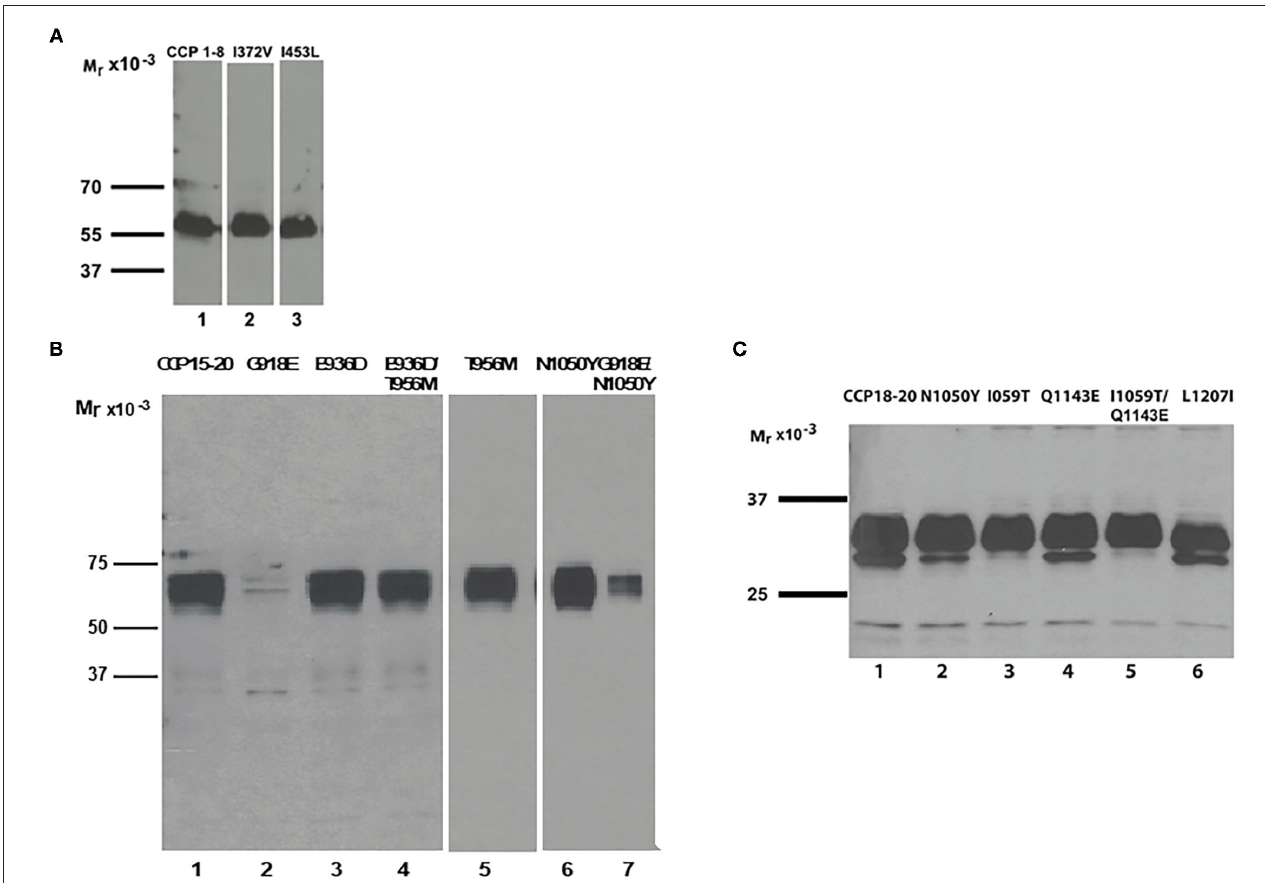
FIGURE 2 | Recombinant expression of CFH variants. Western blots of supernatants from transfected wild-type and variant constructs. (A) Recombinant expression of variants I372V (lane 2) and I453L (lane 3) shows secretion comparable to wild type CCP 1–8 (lane 1). (B) Wild type CCP 15–20 as control (lane 1). Secretion of variant protein G918E is undetectable (lane 2). The SNP N1050Y displays higher secretion than WT (lane 6). The combined variant G918E/N1050Y has markedly reduced secretion (lane 7). Variant T956M has normal secretion (lane 5). Combined variant T956M/E936D and the SNP E936D also demonstrate normal secretion (lanes 3 and 4). (C) Wild type CCP 18–20 as control (lane 1). The SNPs N1050Y, I1059T, Q1143E, and variant L1207I show normal secretion (lanes